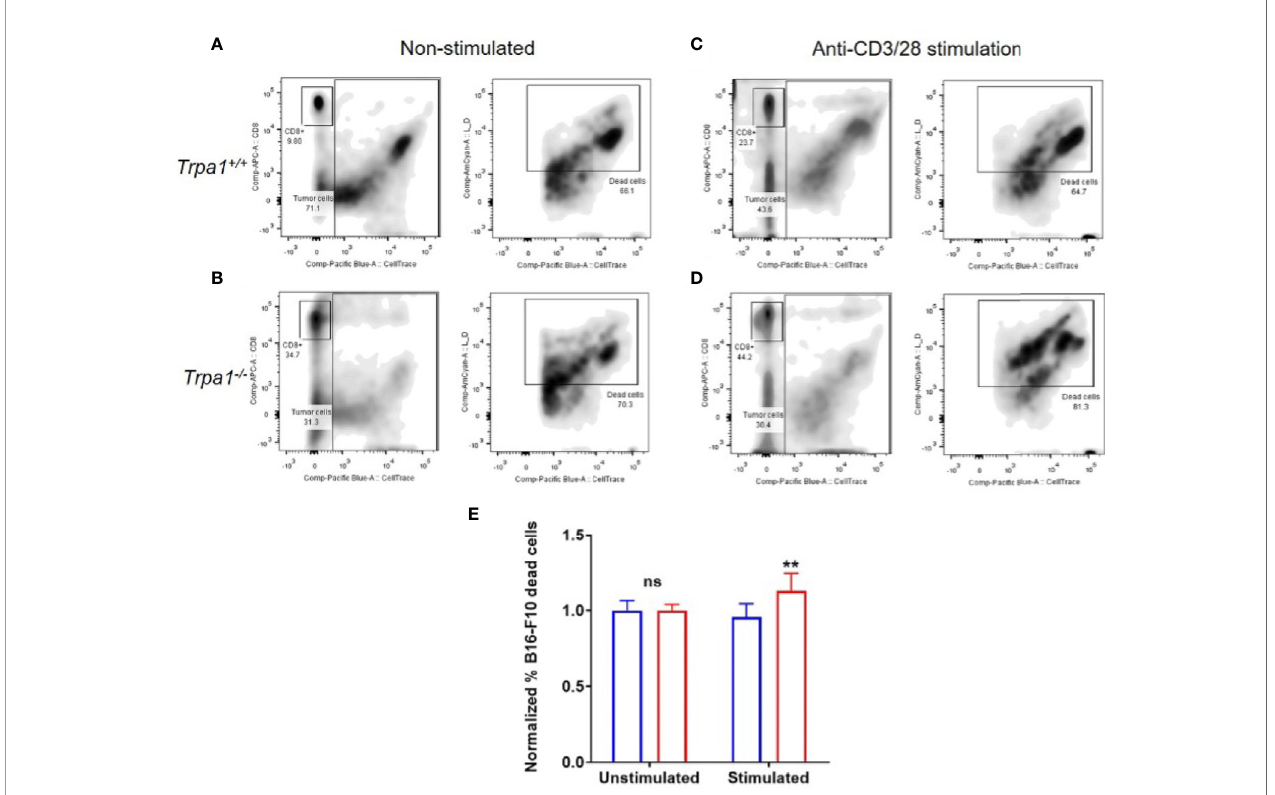
FIGURE 7 | Killing capacity of CD8 + cells from Trpa1 +/+ and Trpa 1 -/- mice co-cultured with B16-F10 cells. A and B) Representative assessment of B16-F10 cell killing by CD8 + T cells from Trpa1 +/+ (A) and Trpa1 -/- (B) mice under non stimulated conditions. C and D) Representative assessment of B16-F10 cell killing by CD8 + T cells from Trpa1 +/+ (C) and Trpa1 -/- (D) mice under CD3/CD28 stimulation. (E) Normalized frequency of B16-F10 cell death by CD8 + T cells from Trpa1 +/+ and Trpa 1 -/- mice; values are presented as the mean (n = 3 and 6 for unstimulated and stimulated group, respectively) ± SD. Statistical analyses were performed by Student ’ s t -test. **p < 0.01, ns, not signi fi